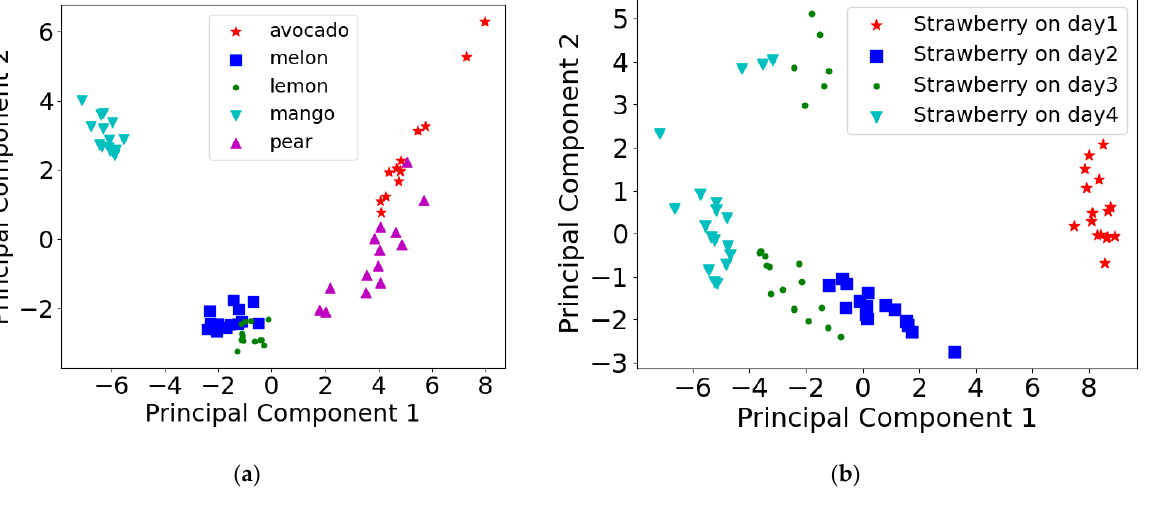
Figure 5. ( a ) The PCA plot for features extracted from sensor conductance responses of different types of fruits by equation (1) fitting, with principal component 1 (PC1) accounting for 42.5% and principal component 2 (PC2) accounting for 16.1%. ( b ) PCA plot for features extracted from sensor conductance responses of strawberry on different storage days by equation (1) fitting, with PC1 accounting for 60.9% and PC2 accounting for 8.7%.